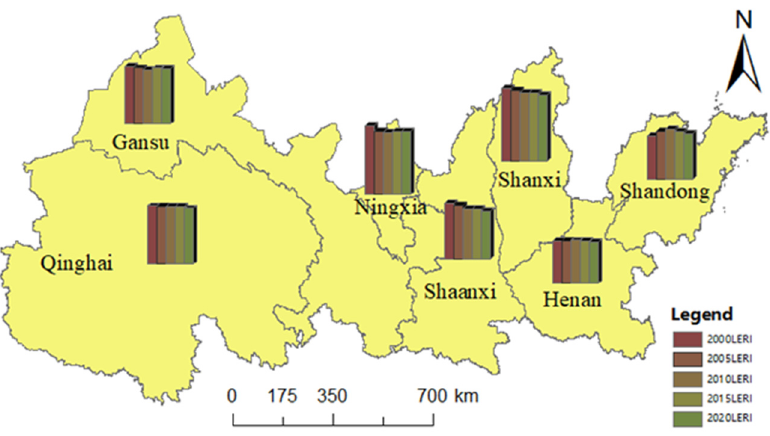
Figure 4. Average LERI values for provinces from 2000 to 2020.